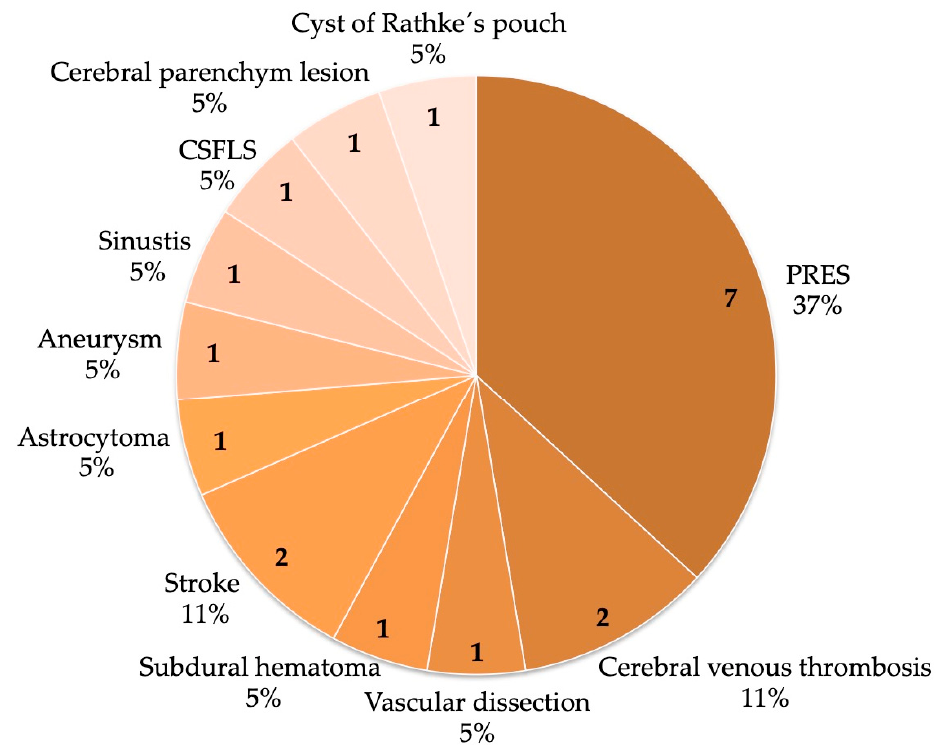
Figure 2. Abnormal findings in neuroimaging PRES = posterior reversible encephalopathy syndrome, CSFLS = cerebrospinal fluid leak syndrome. The absolute values are given in bold within the pie; the percent values refer to the 19 patients.